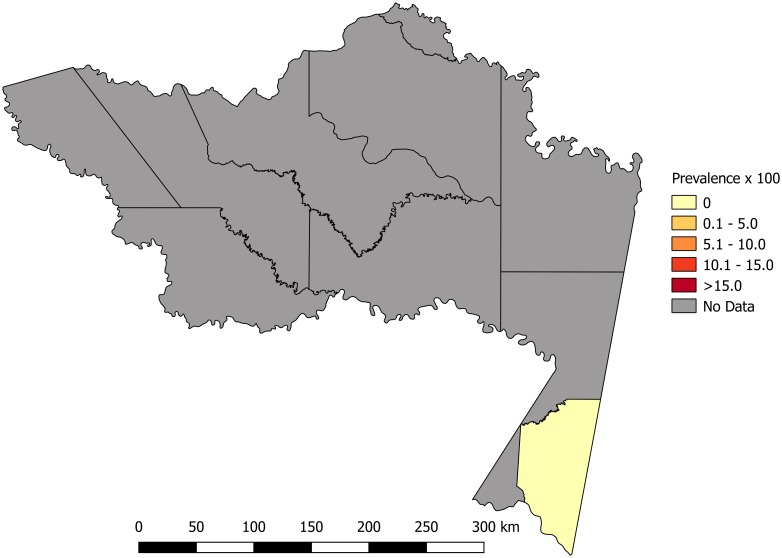
Map of the municipalities of Amazonas showing the distribution of observed Chagas disease prevalence in studies published from 2007 to November 2017.